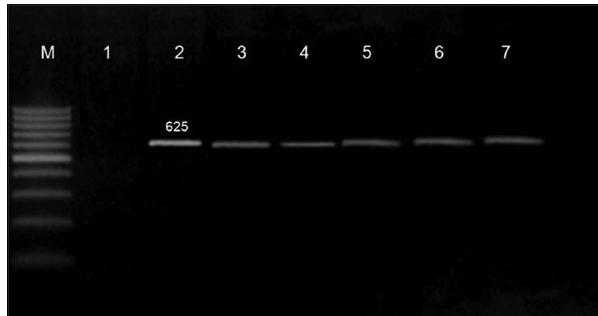
Figure-1: PCR result for E. coli O157:H7 detection. Lane M: 100 bp ladder (Norgen Bioteck), Lane 1: Negative, Lane: 2,3,4,5, 6 and 7: Table-1: Frequency distribution of E. coli O157:H7 in milk products and patients. Positive samples